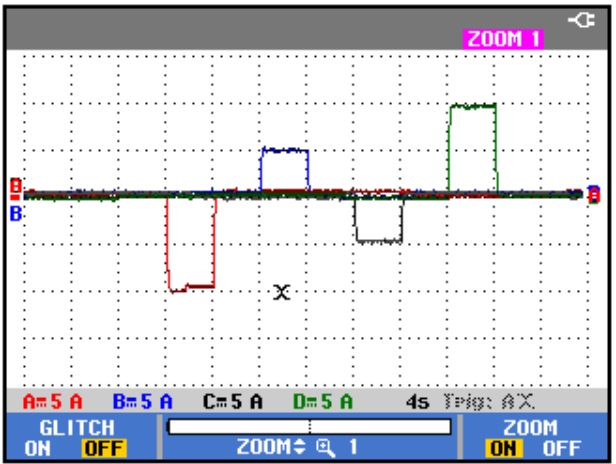
Figure 24. Mitigation signals during sequential current attacks.